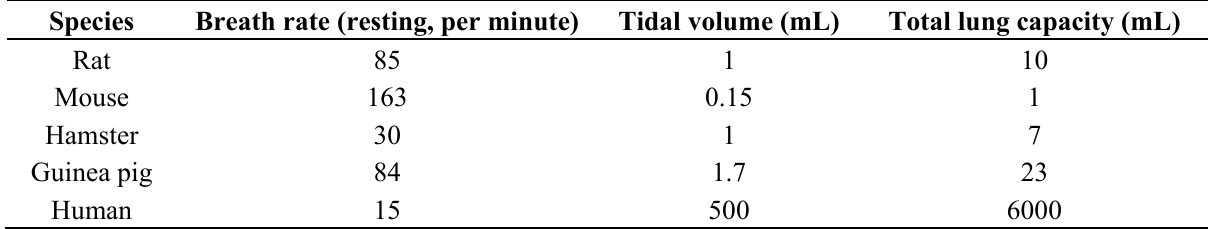
Table 2. Comparison of physiological lung parameters between laboratory animals and humans. Species Breath rate (resting, per minute) Tidal volume (mL) Total lung capacity (mL) Rat 85 1 10 Mouse 163 0.15 1 Hamster 30 1 7 Guinea pig 84 1.7 23 Human 15 500